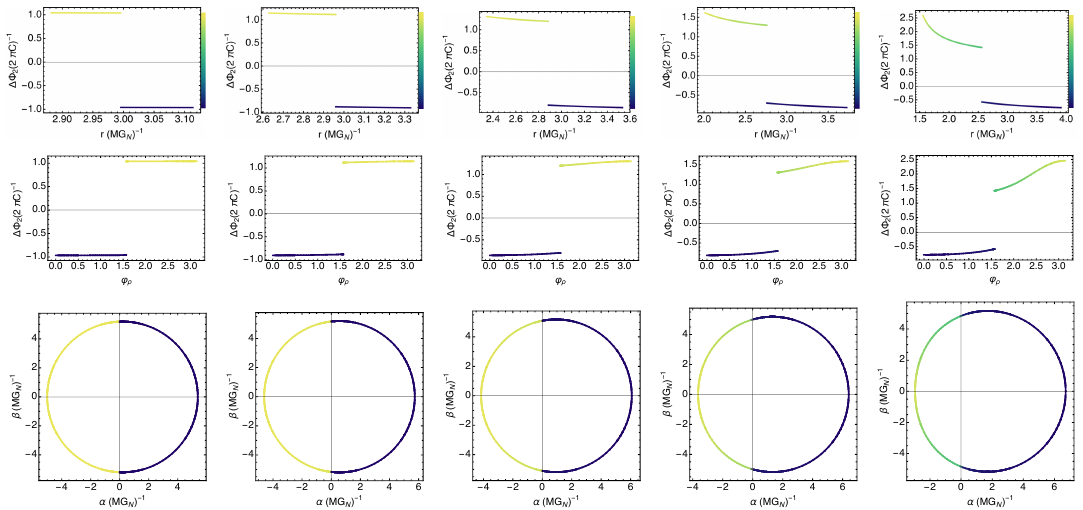
Figure 2 . The relative polarizations of linear polarized light ∆Φ 2 from the n th and ( n + 2) th subrings of the photon ring of a black hole that is pierced by a cosmic string. All plots are given for a cosmic string that coincides with the black hole spin axis and has an orientation which corresponds to the + sign in (3.18). Plots are provided for various black hole spin parameters a for the given observer inclination θ o = 70 ◦ . From left to right: a ( MG N ) − 1 = 0 . 1 , a ( MG N ) − 1 = 0 . 3 , a ( MG N ) − 1 = 0 . 5 , a ( MG N ) − 1 = 0 . 7 , a ( MG N ) − 1 = 0 . 9 . For each chosen a , there are three plots: the first plot (top) shows C − 1 ∆Φ 2 as a function of the radius r at which photons can circle the black hole. The plotted range of r is r − ( a ) ≤ r ≤ r + ( a ) . The constant C is defined in (2.6), r − and r + are given in (3.4). As discussed in the main text, photons from orbits of a given r that reach a distant observer generally arrive at two different angular coordinates ϕ ρ on the screen of the observer. The second (middle) and third (bottom) plots show C − 1 ∆Φ 2 as a function of the angular coordinate ϕ ρ . In the second plots C − 1 ∆Φ 2 is plotted against ϕ ρ in the range 0 ≤ ϕ ρ ≤ π , omitting the intervall π ≤ ϕ ρ ≤ 2 π that is symmetric to 0 ≤ ϕ ρ ≤ π since it is comprised of photons from the same r (as just mentioned). The third plots show the shape of the photon ring indicating different values of C − 1 ∆Φ 2 by different colors (the Cartesian coordinates α and β on the screen are related to ϕ ρ via (3.13)). For convenience, these colors are also used in the first and second plots. The color profile is indicated in the first plots on the right. Although difficult to see in these plots (because θ o = 70 ◦ is too close to θ o = 90 ◦ ), not all values of C − 1 ∆Φ 2 that appear in the first plot show up in the second and third plots. (This is because observers with θ o 6 = 90 ◦ can only probe photons that come from a subset of orbits of the radii r that are plotted in the first plot.) This effect becomes more apparent in figure 3 in the plots with θ o (cid:28) 90 ◦ . Note that, for each chosen a , we have normalized the color profile differently, as can be seen on the right in the first plots. Therefore, the same color in plots for different a not necessarily represent the same value of C − 1 ∆Φ 2